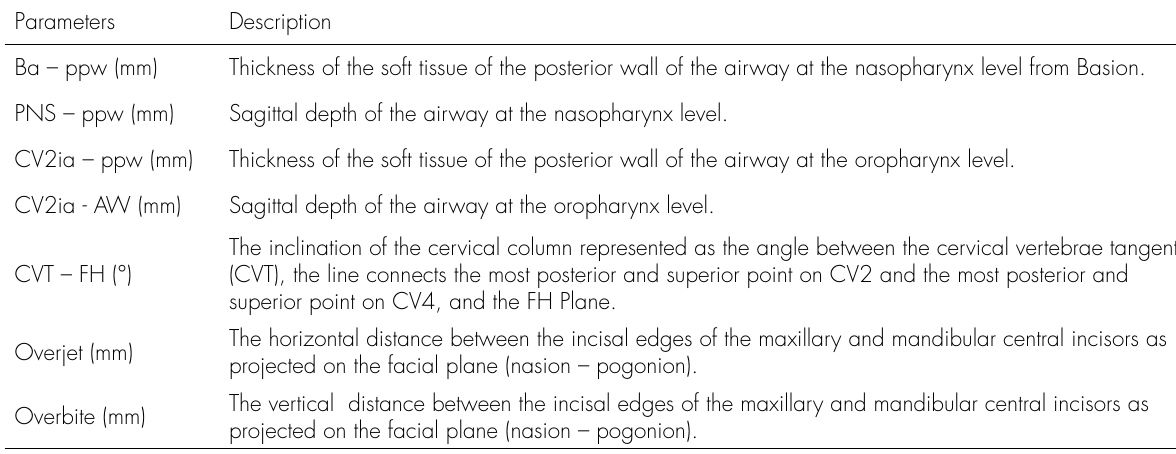
Table II. The 3D measurements of the craniofacial complex used in the study. Parameters Description